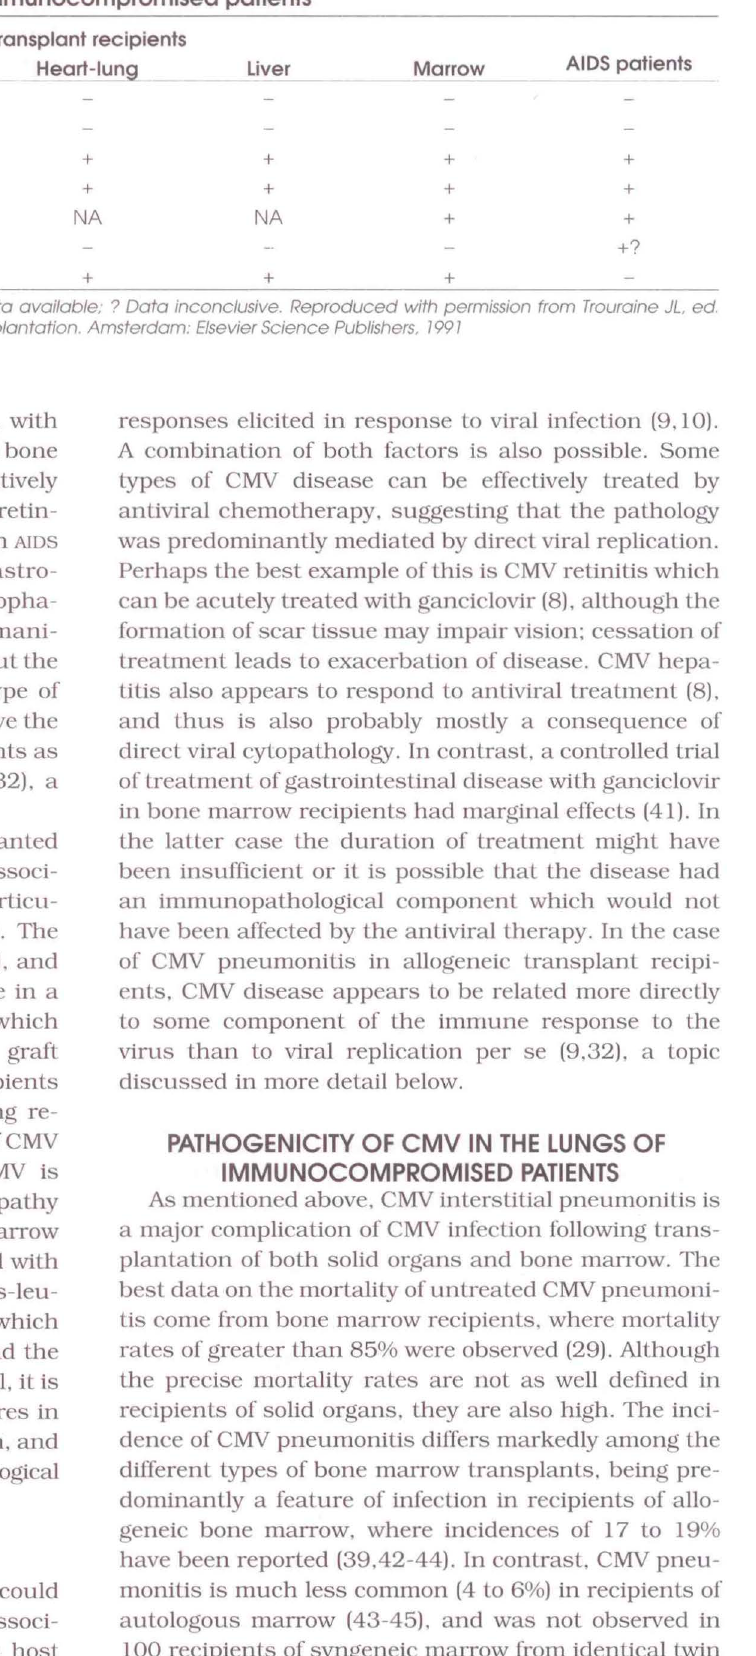
Major sites of cytomegalovirus pathogenicity in immunocompromised patients Transplant recipients Site of infection Renal Heart Heart-lung Liver Marrow AIDS